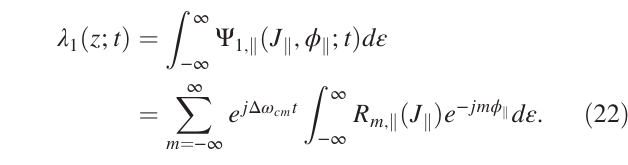
FIG. 5. Normalized (to the low-intensity synchrotron tune) mode-frequency shifts from GALACLIC in the case of a broadband resonator impedance (with a quality factor of 1 and a resonance frequency f and for a PAD longitudinal distribution: (left) real part and (right) imaginary